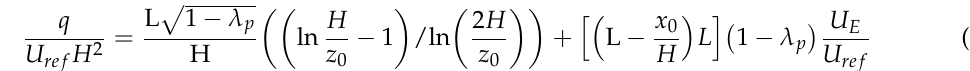
Figure 7. The relationship between frontal area ratio (